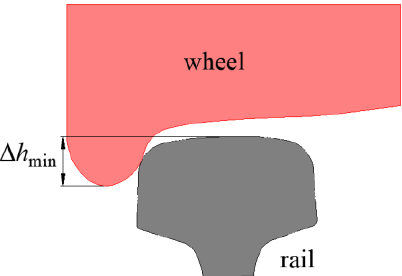
Figure 6. Scenario of slight climb of the wheel in the extreme inscribing state.